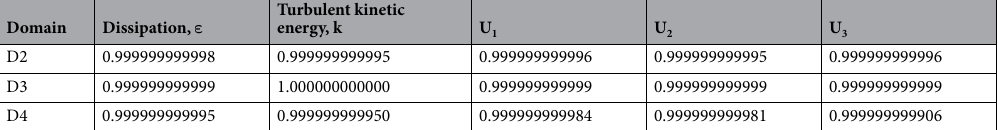
Table 5. Nash-Sutcliffe efficiency values between the flow variables of the original domain (D1) at t = 20 s and those of Domain 2 (D2) at t = 10 s, Domain 3 (D3) at t = 40 s, and Domain 4 (D4) at 11.25 s. Nash-Sutcliffe efficiency values are calculated between the variables of the original domain (k, ε , U 1 , U 2 , and U 3 ), and their corresponding transformed variables ( β α k k , β ε α ε , β α U , (40 × 40 × 40) computational